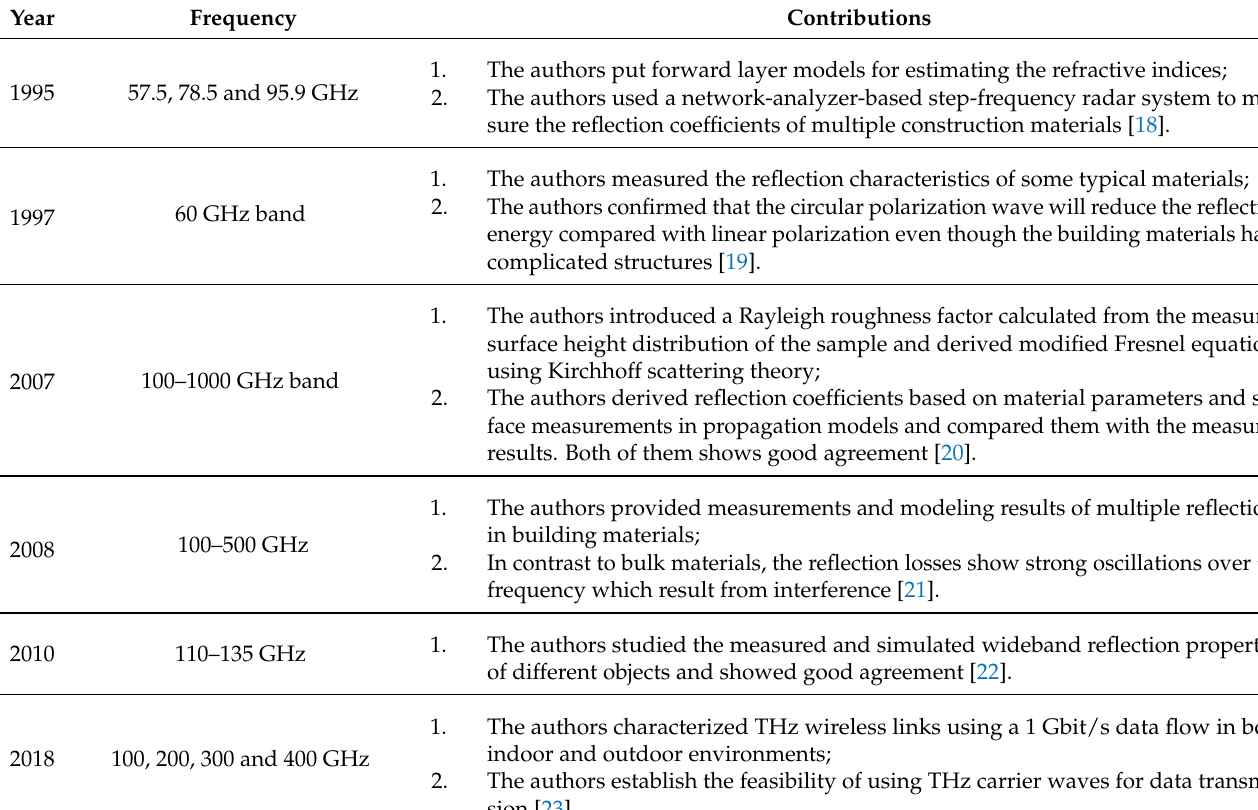
Table 1. Reference Review of Exploring Reflection Characteristics.